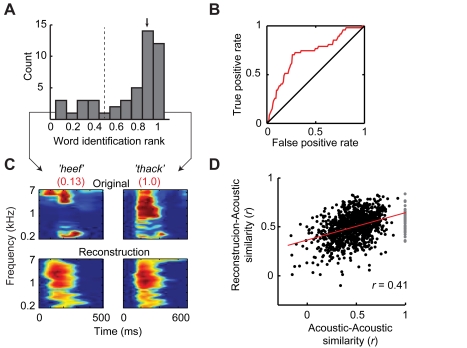
Word identification.Word identification based on the reconstructed spectrograms was assessed using a set of 47 individual words and pseudowords from a single speaker in a high density 4 mm grid experiment. The speech recognition algorithm is described in the text. (A) Distribution of identification rank for all 47 words in the set. Median identification rank is 0.89 (black arrow), which is higher than 0.50 chance level (dashed line; p<0.0001; randomization test). Statistical significance was assessed by a randomization test in which a null distribution of the median was constructed by randomly shuffling the word pairs 10,000 times, computing median identification rank for each shuffle, and calculating the percentile rank of the true median in the null distribution. Best performance was achieved after smoothing the spectrograms with a 2-D box filter (500 ms, 2 octaves). (B) Receiver operating characteristic (ROC) plot of identification performance (red curve). Diagonal black line indicates no predictive power. (C) Examples of accurately (right) and inaccurately (left) identified words. Left: reconstruction of pseudoword “heef” is poor and leads to a low identification rank (0.13). Right: reconstruction of pseudoword “thack” is accurate and best matches the correct word out of 46 other candidate words (identification rank = 1.0). (D) Actual and reconstructed word similarity is correlated (r = 0.41). Pair-wise similarity between the original spectrograms of individual words is correlated with pair-wise similarity between the reconstructed and original spectrograms. Plotted values are computed prior to spectrogram smoothing used in the identification algorithm. Gray points denote the similarity between identical words.